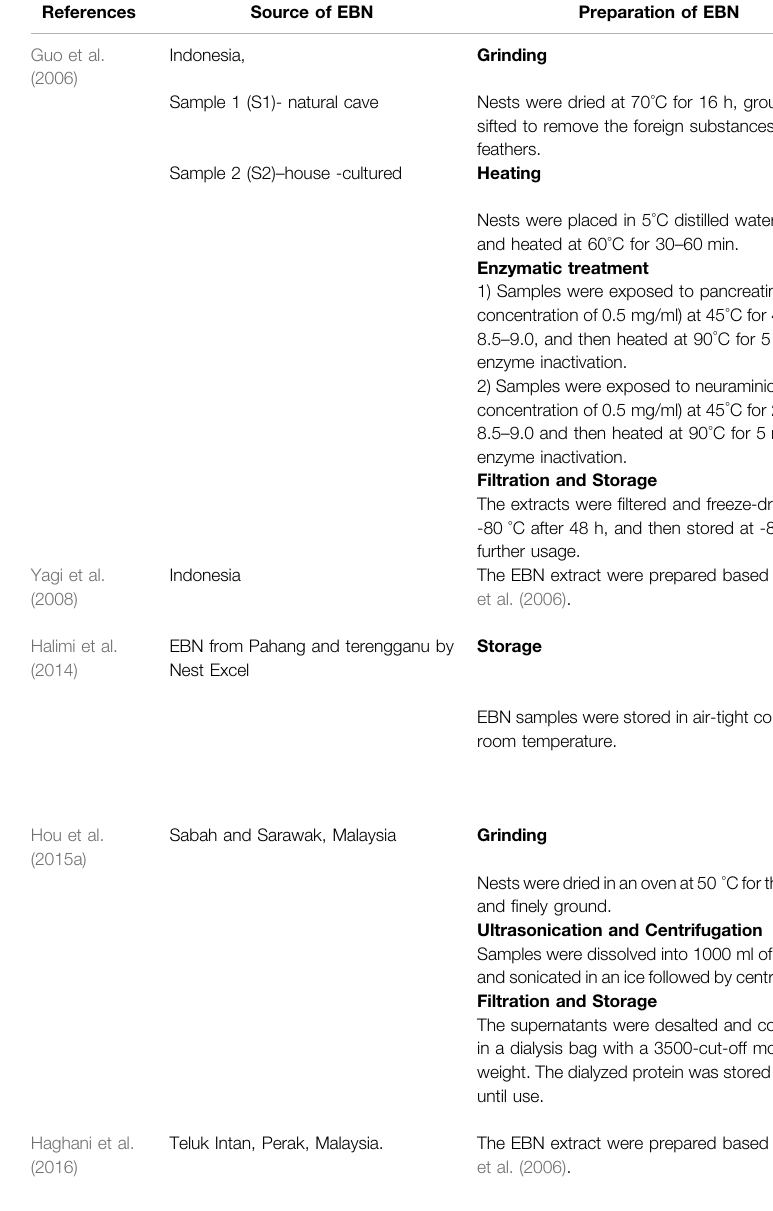
TABLE 4 | Analysis of EBN